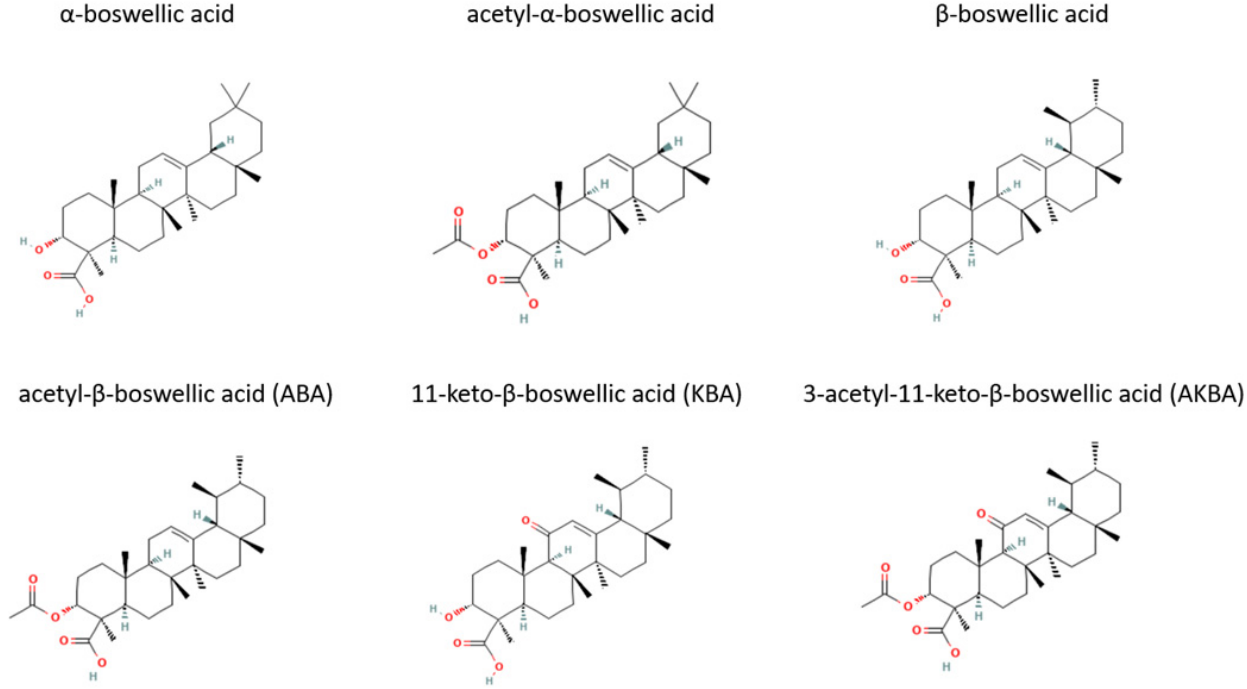
Figure 2. Chemical structure of common boswellic acids found in frankincense. Two-dimensional chemical structures were obtained from Pub Chem. Pub Chem CIDs are as follows: α -boswellic acid, 637234; acetyl - α -boswellic acid, 15181201; β -boswellic acid, 168928; acetyl- β -boswellic acid (ABA), 11386458; 11-keto- β -boswellic acid (KBA), 9847548; 3-acetyl-11-keto- β -boswellic acid (AKBA), 11168203.